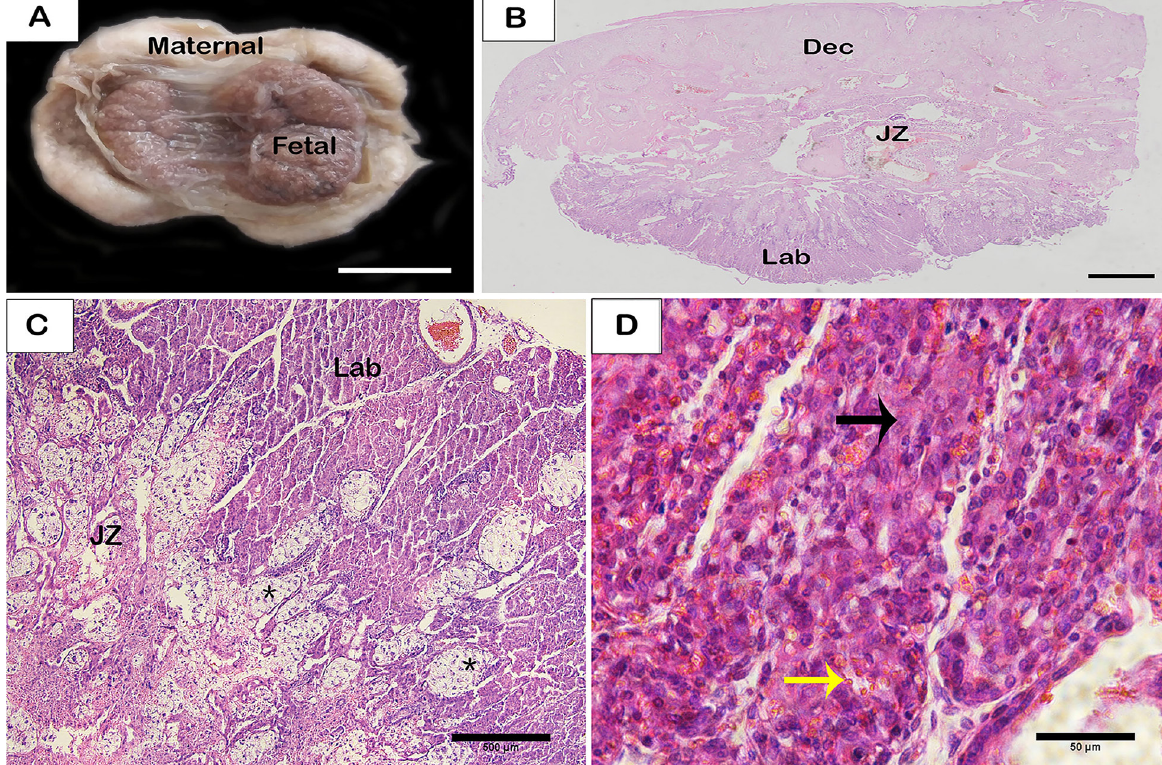
Figure 1. a) Fetal and maternal portion of discoidal and bilobular placenta of New Zealand rabbit on the 16 th day of gestation (Bar scale: 1 cm). b) Photomicrography of the placental compartments (labyrinth, junctional and decidua zones on the 16 th day; scale bar: 1mm). c) Trophoblastic cells of the labyrinth (Lab) and spongiotrophoblasts (asterisk) of the junctional zone (JZ) (20 th day; Scale bar: 500 μm). d) Trophoblasts (black arrow) in contact with maternal blood (yellow arrow, 20 th day; Scale bar: 50 μm). Dec: decidua; JZ: junctional zone; Lab: labyrinth. Hematoxylin & Eosin staining.